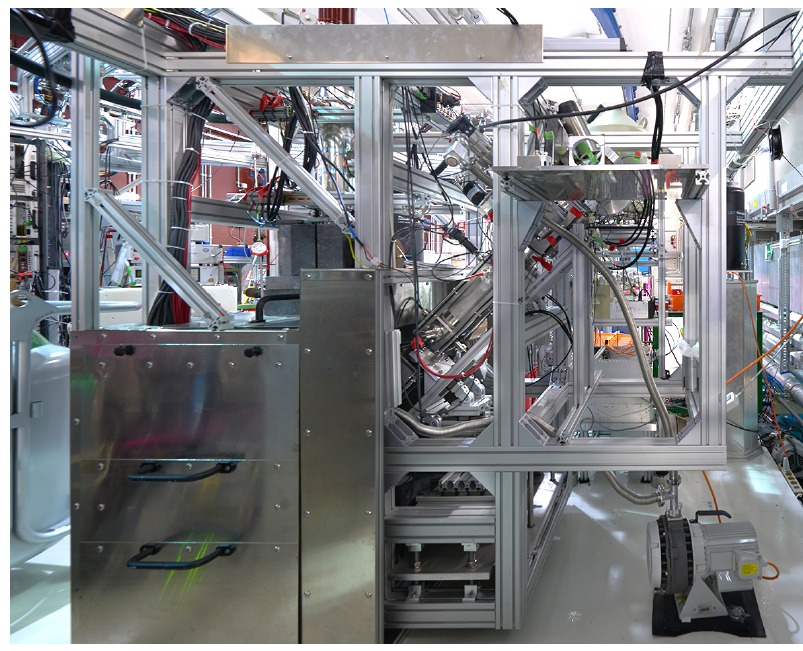
Figure 1: Instrument SPM at NEPOMUC (Copyright by W. Schürmann,